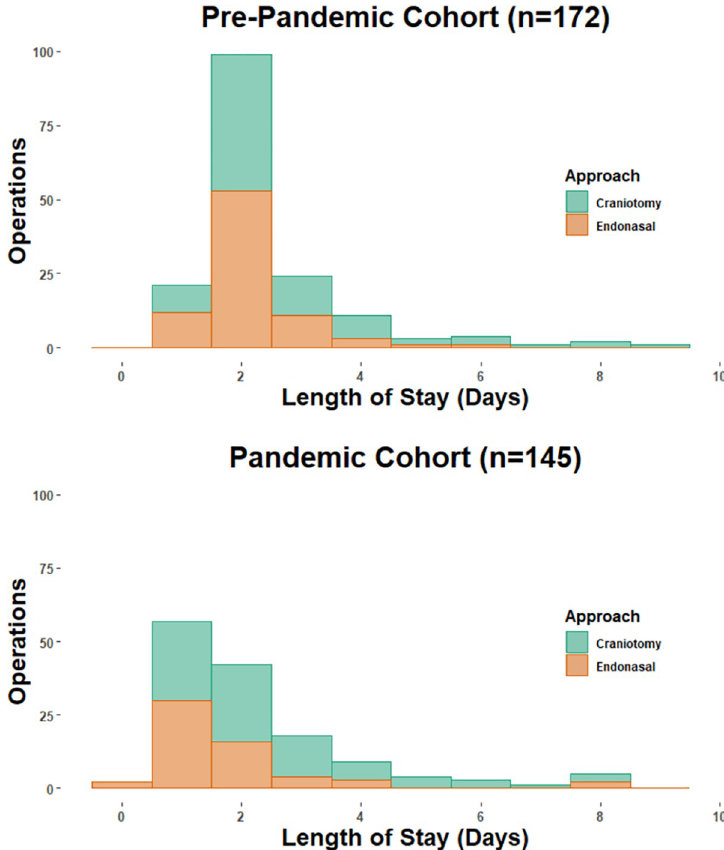
Fig 1. Pre-pandemic versus pandemic hospital LOS from POD 0–10 for craniotomy and endonasal cohorts. Overall LOS of 1day or less increased from 21 (12.2%) to 60 (41.4%), p < 0.001. There were 6 and 4 patients (all craniotomies) in the pre-pandemic and pandemic cohorts who had LOS > 10 days, respectively (not shown for graph readability). LOS range for craniotomy and endonasal approach was 1–20 days and 0–8 days, respectively.